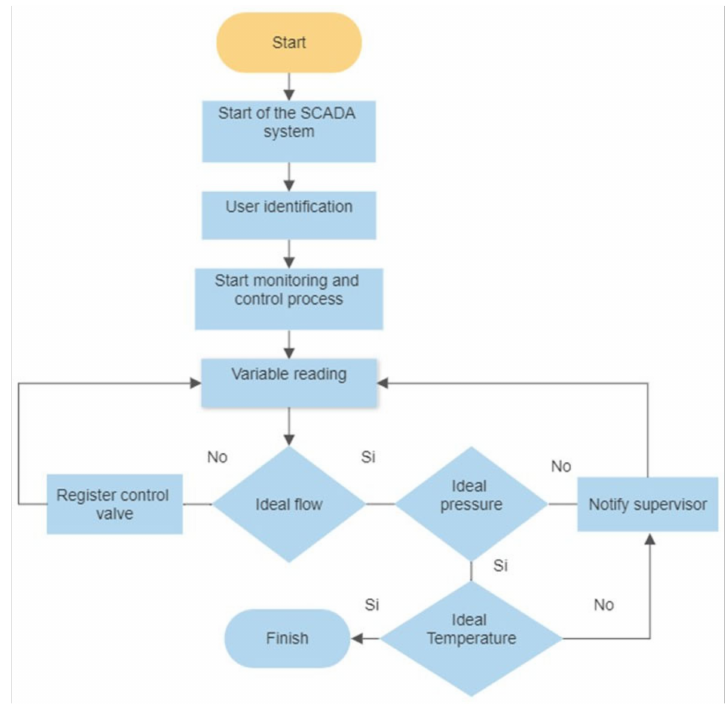
Figure 6. System flow